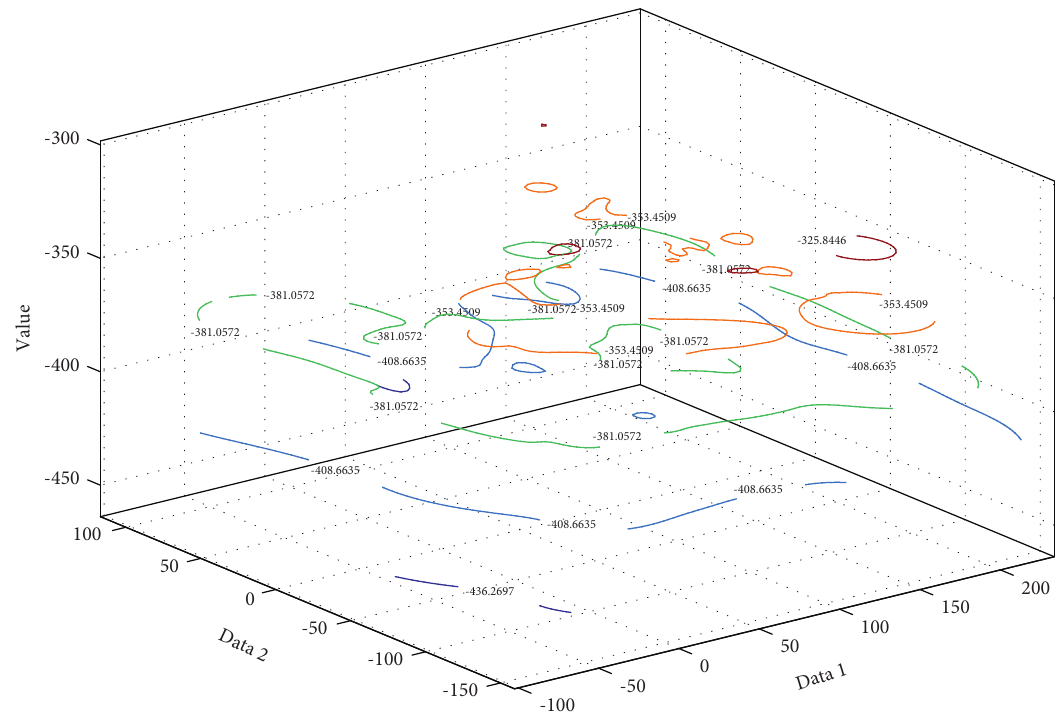
Figure 8: Value versus